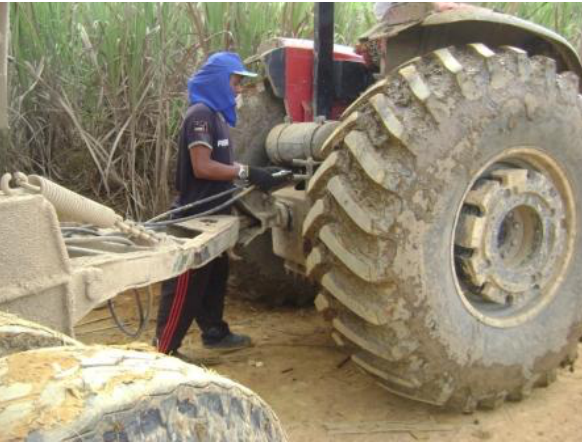
Figure 2. Lashing of cane cargo in the truck or in the trailers, by means of ropes thrown over the load (working activity